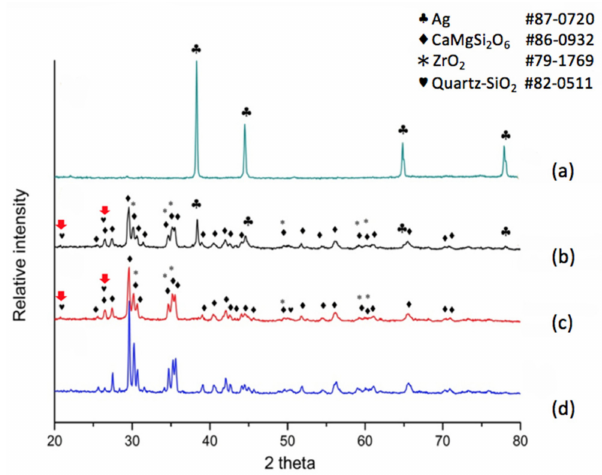
Figure 3. XRD patterns for different positions of a modified CaO-MgO-2SiO 2 diopside system with nano-sized SiO 2 addition co-fired with a commercial silver electrode. ( a ) electrode surface; ( b ) below surface 24 µ m; ( c ) below surface 40 µ m; ( d ) crystallized CaO-MgO-2SiO 2